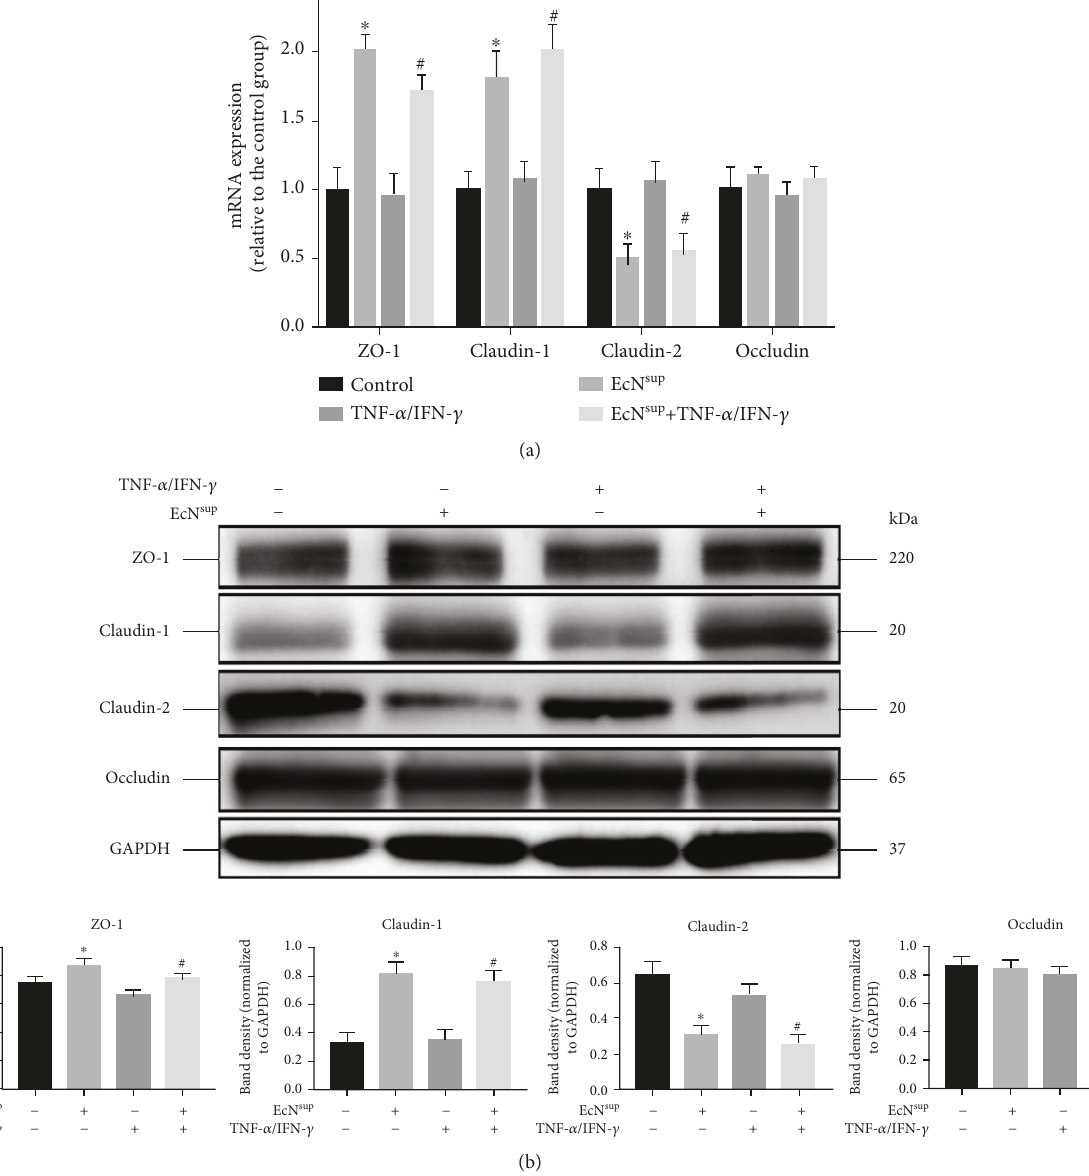
Figure 3: EcN sup reversed the downregulation of TJ proteins induced by TNF- α /IFN- γ at both mRNA and protein levels. The total protein or RNA of monolayers was harvested after incubation for 48h with or without 10 ng/mL TNF- α and 10ng/mL IFN- γ in the presence or absence of 100ng/mL EcN sup . The mRNA and protein level of ZO-1, Claudin-1, Claudin-2, and Occludin were tested by (a) RT-qPCR and (b) western blot, respectively. Results were expressed as the mean ± SEM ( n = 3 ). ∗ P < 0 05 vs. control. # P < 0 05 vs. TNF- α /IFN- γ (Figure 4). In normal Caco-2 monolayers, ZO-1 and Occlu- results suggested that TNF- α /IFN- γ resulted in the abnormal din immuno fl uorescence showed smooth edges and typical distribution of these TJ proteins. However, as shown, the “ chicken wire ” shapes (Figure 4, a addition of EcN sup inhibited the localization changes of , a , and a ). Incubation 1 2 3 with EcN sup revealed the similar phenomenon (Figure 4, b ZO-1 and Occludin induced by TNF- α /IFN- γ , and immuno- , 1 fl uorescence remained a typical “ chicken wire ” pattern b , and b ). However, after being treated with 10 ng/mL 2 3 (Figure 4, d TNF- α /IFN- γ for 48 h, the cell edges become serrated, the , d , and d ). 1 2 3 intercellular contact sites changed, and the ZO-1 network pattern was disrupted by the irregular labeling intensity; some parts are almost discontinuous. Occludin localization changes are similar to ZO-1 (Figure 4, c , c , and c ). These 1 2 3